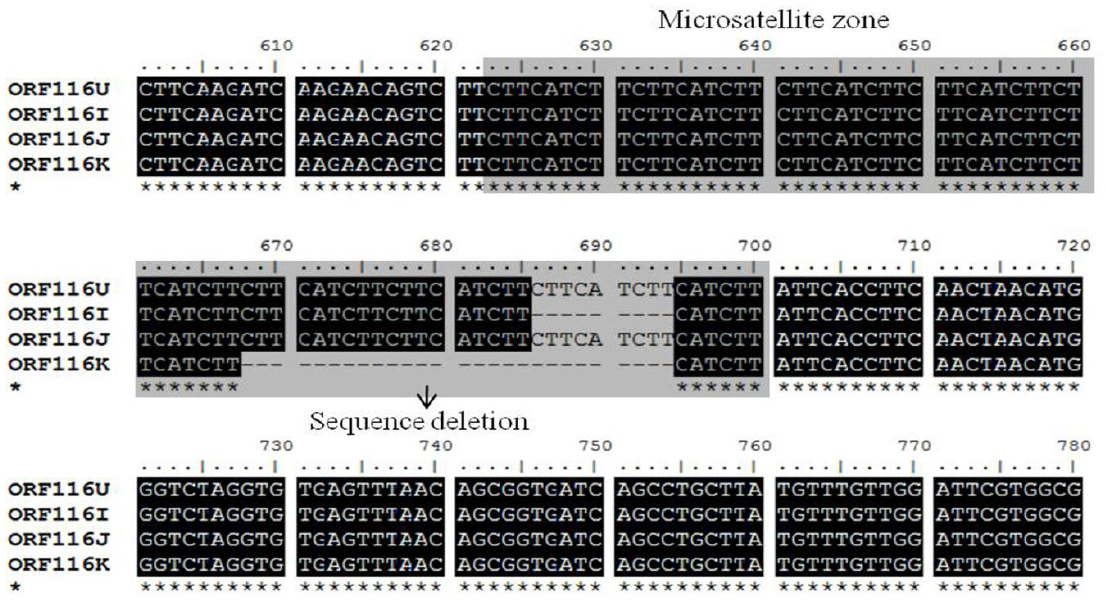
Figure 3. Nucleotide sequences of the glycoprotein gene (open reading frame [ORF]116) of Korean CyHV-3 (KHV-K) and those of the USA (KHV-U), Israel (KHV-I), and Japan (KHV-J) CyHV-3 were aligned using BioEdit software. Several sequence deletions were observed in the microsatellite zone in